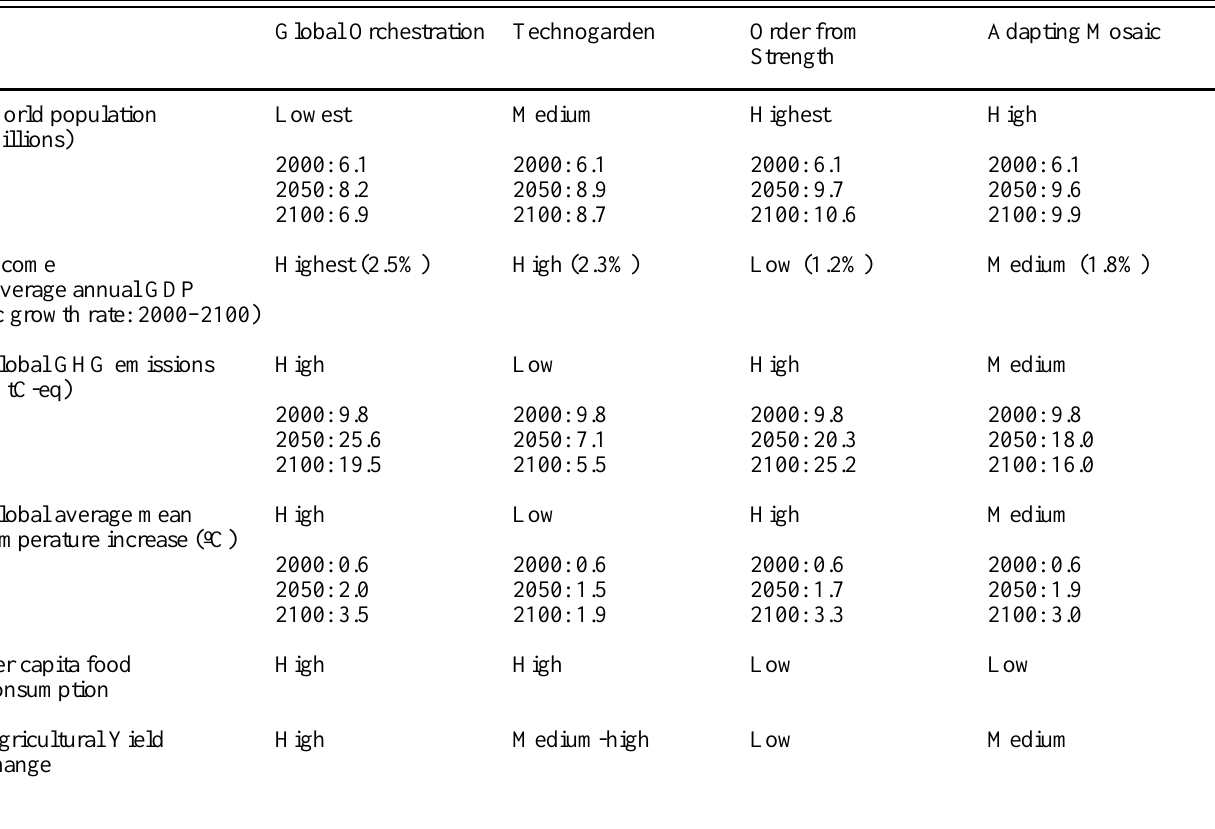
Table 1. Main assumptions and results in the model about drivers of ecosystem change in each scenario. Global Orchestration Technogarden Order from Adapting Strength